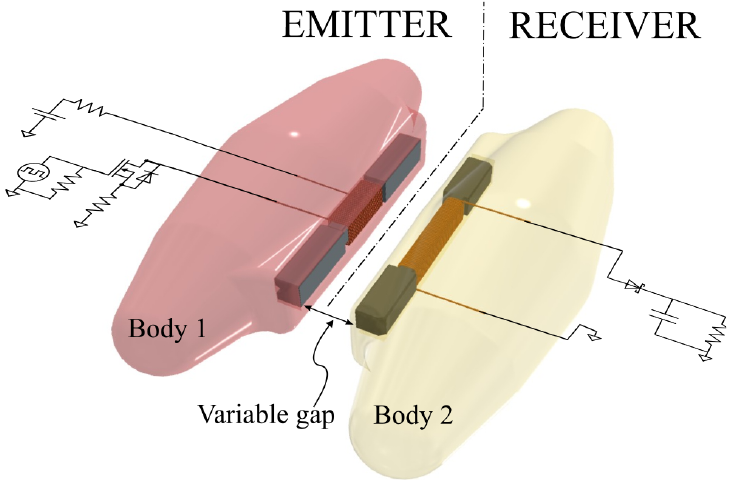
Figure 1. Conceptual schematization of the